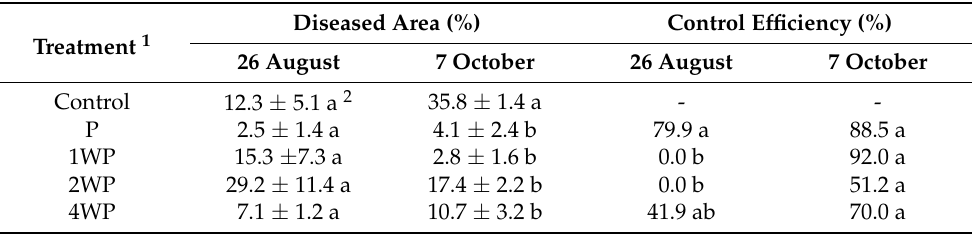
Table 2. Diseased area and control efficiency of large patch disease in zoysiagrass after the application of various treatments containing Bacillus subtilis SA-15 (WP) and pencycuron (P). Diseased Area (%) Treatment 1